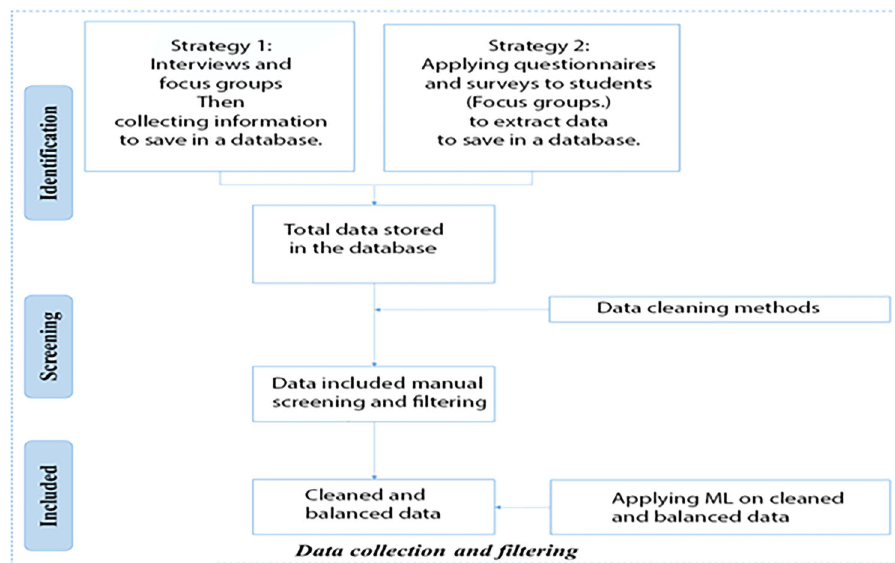
Fig. 1 Methods of data collecting in qualitative